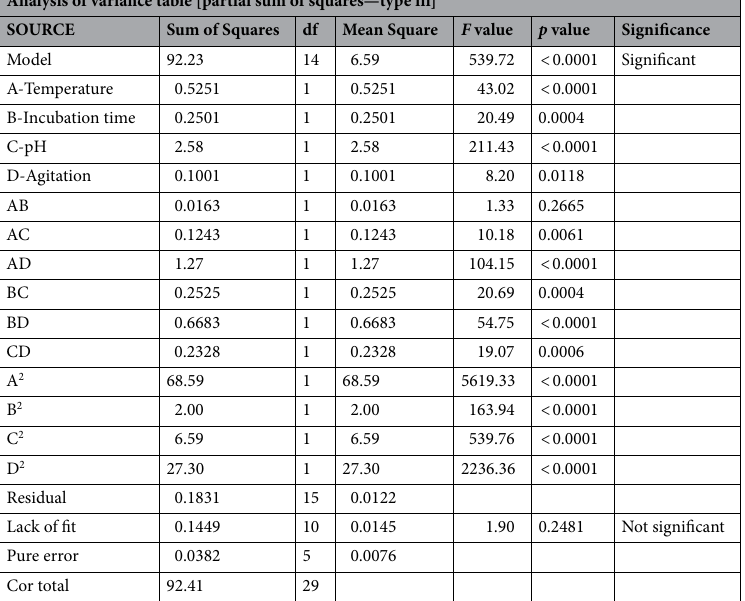
Table 4. ANOVA for the CCD quadratic model. STD. DEV. 0.1105, MEAN 7.10, C.V. % 1.56. R 2